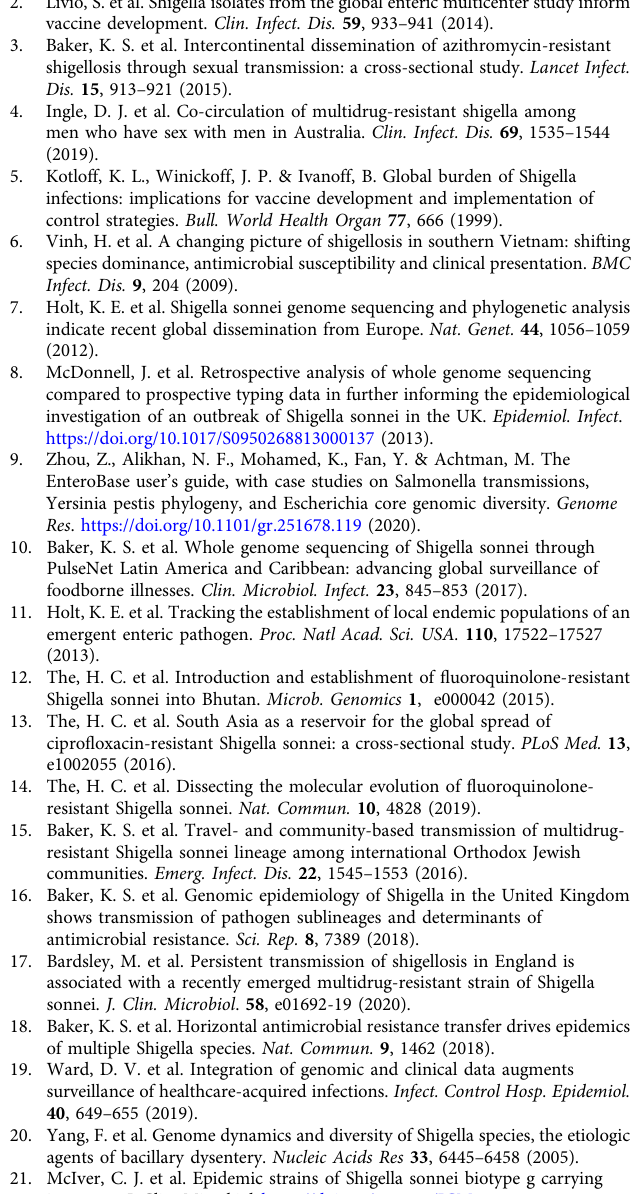
Figshare, https://doi.org/10.6084/m9. fi gshare.13072646 AMR genes were detected from CARD database v3.0.8, available at